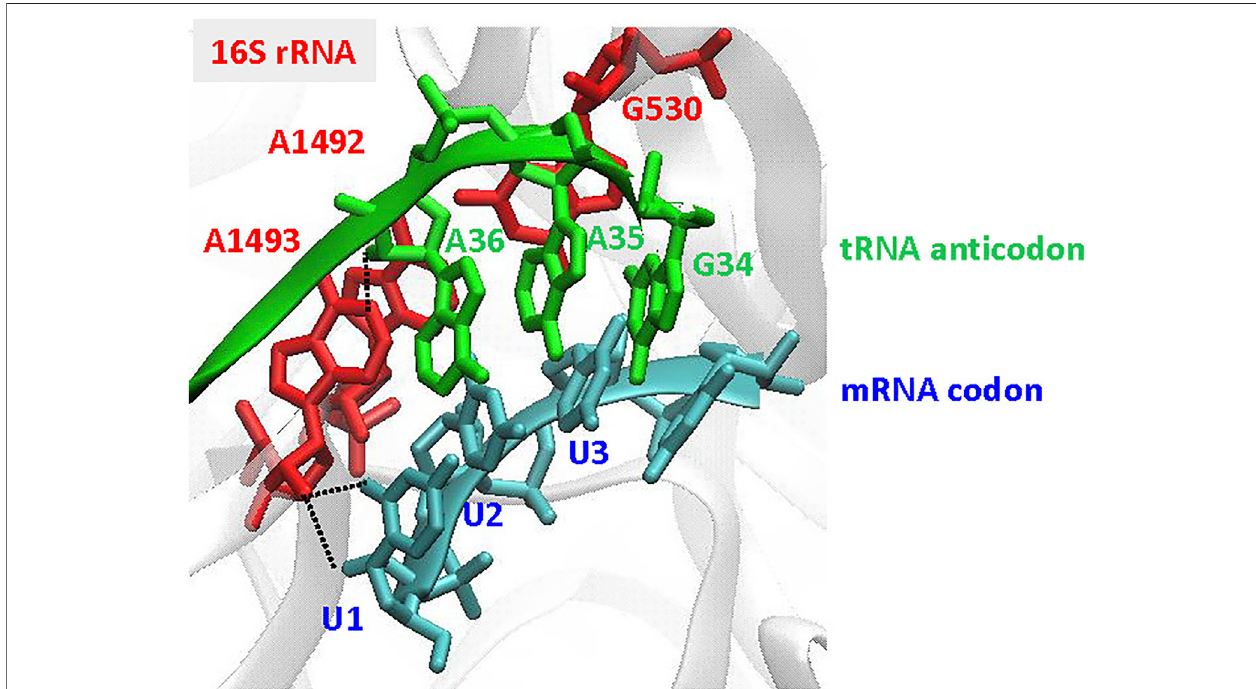
FIGURE6| Recognitionofthecodon-anticodon interaction at theribosome. Theillustration isfocusedon thedecoding siteofthe 30Ssubunit, showingtheA-site codon (UUU in blue) and the tRNA anticodon (GAA in green), using the coordinates in PDB: 1IBM (Ogle et al., 2001). The important nucleotides, G530, A1492, and A1493, in 16S rRNA are indicated in red. Type I A-minor motif interactions, found in A1493 at the fi rst codon-anticodon position (U1 A36), are indicated by black dotted lines.